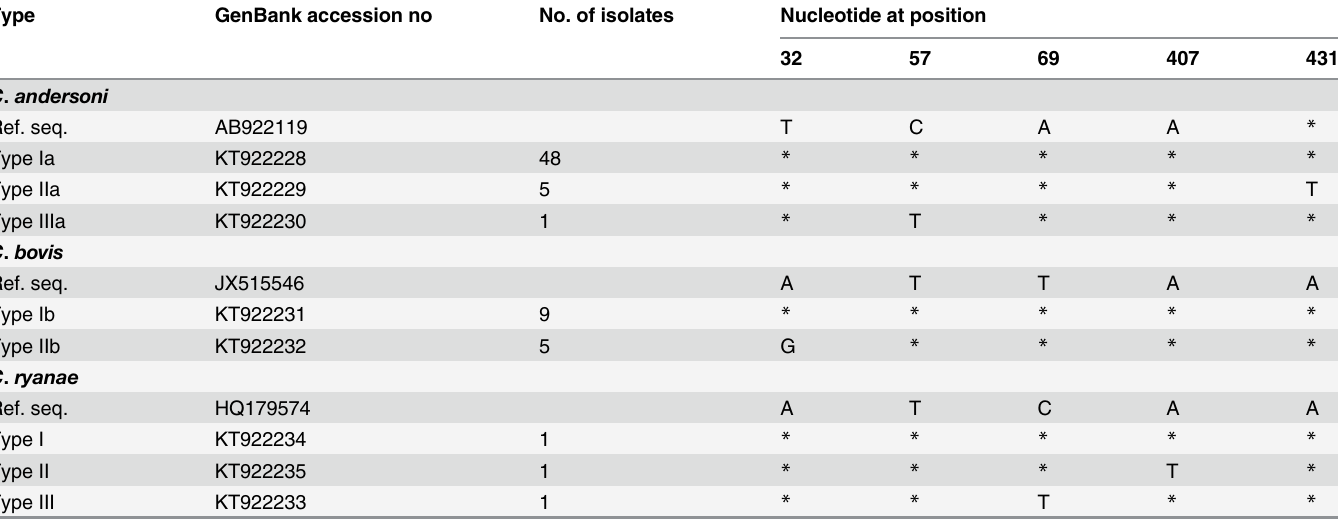
Key: Asterisks ( * ) represent nucleotide identity to the reference